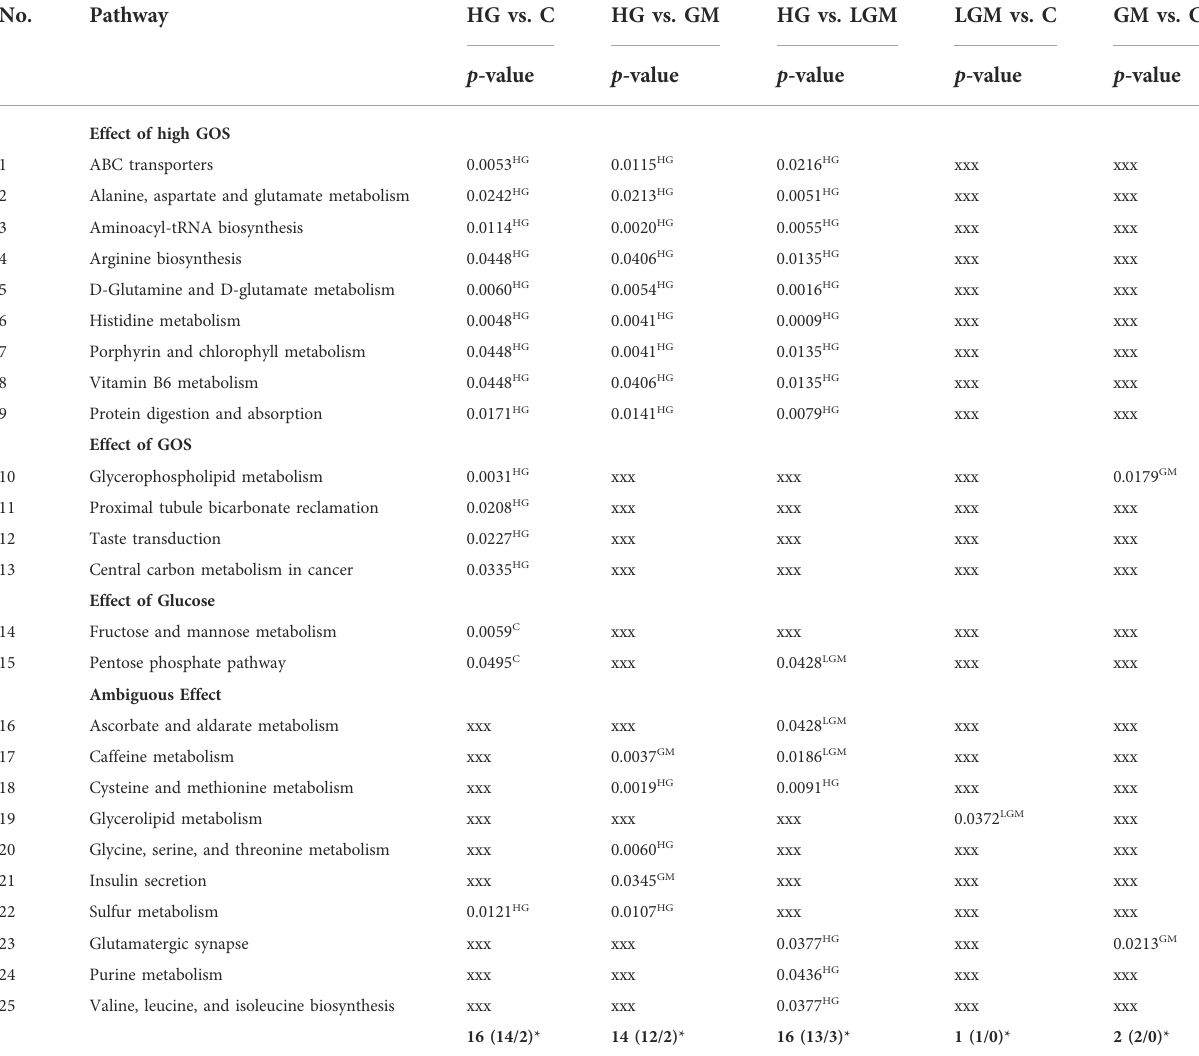
TABLE 4 Signi fi cantly regulated pathways based on the various comparisons with p-values and regulation pattern; superscripts indicate signi fi cant upregulation of the pathway in the corresponding treatment.